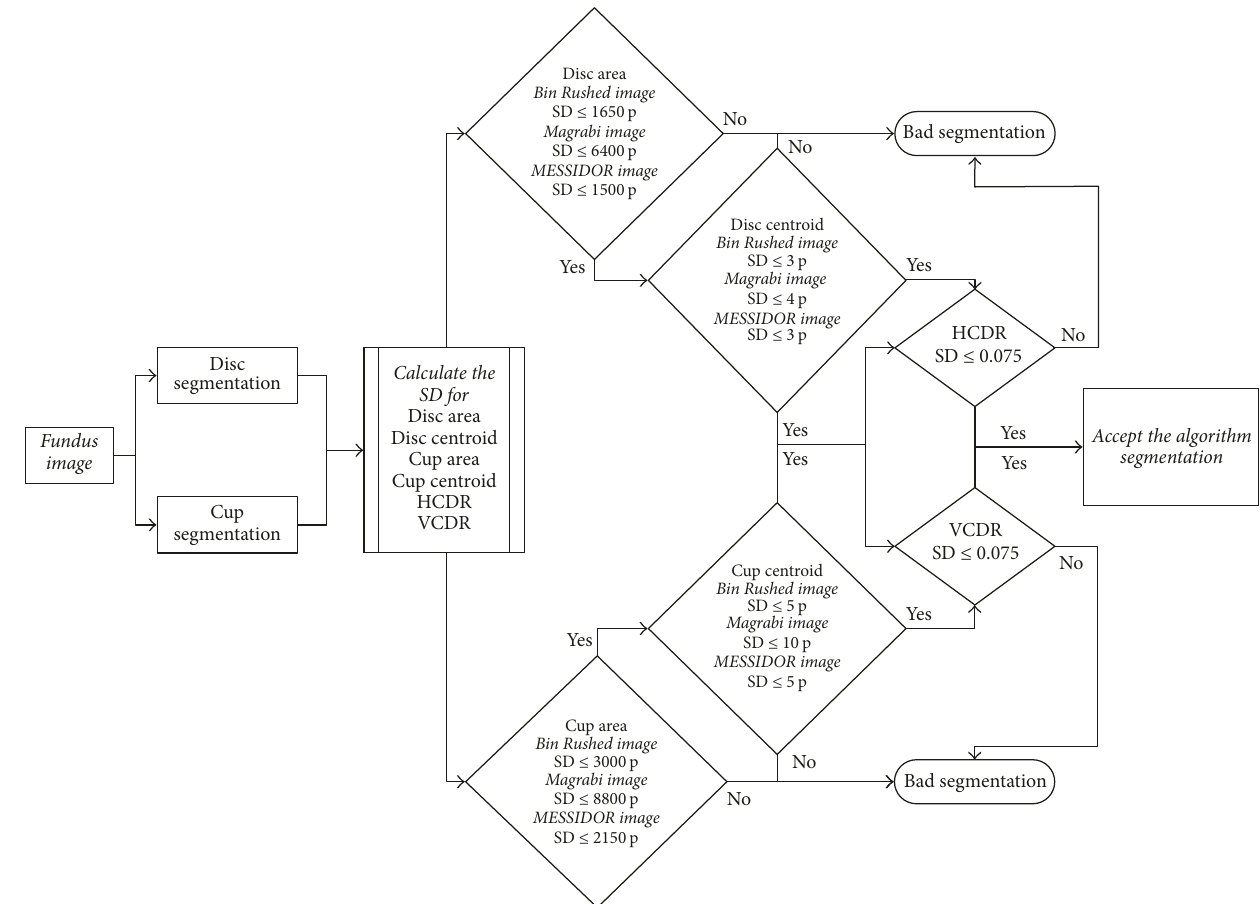
Figure 12: Flowchart for the algorithm